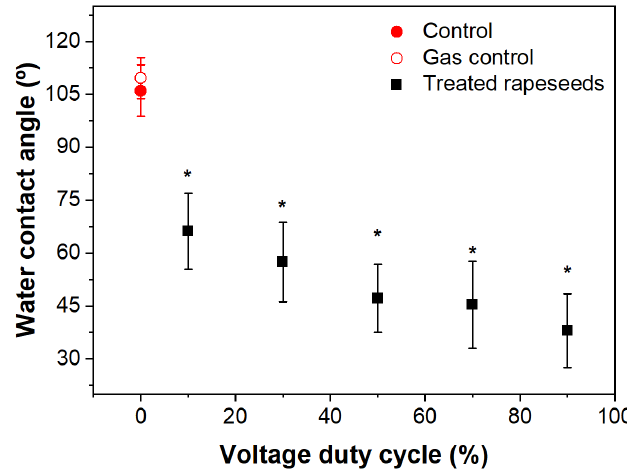
Figure 7. Water contact angle of rapeseed treated with the funnel reactor for 3 min using different voltage duty cycle values. (*) Represents a statistically significant difference ( p < 0.001).